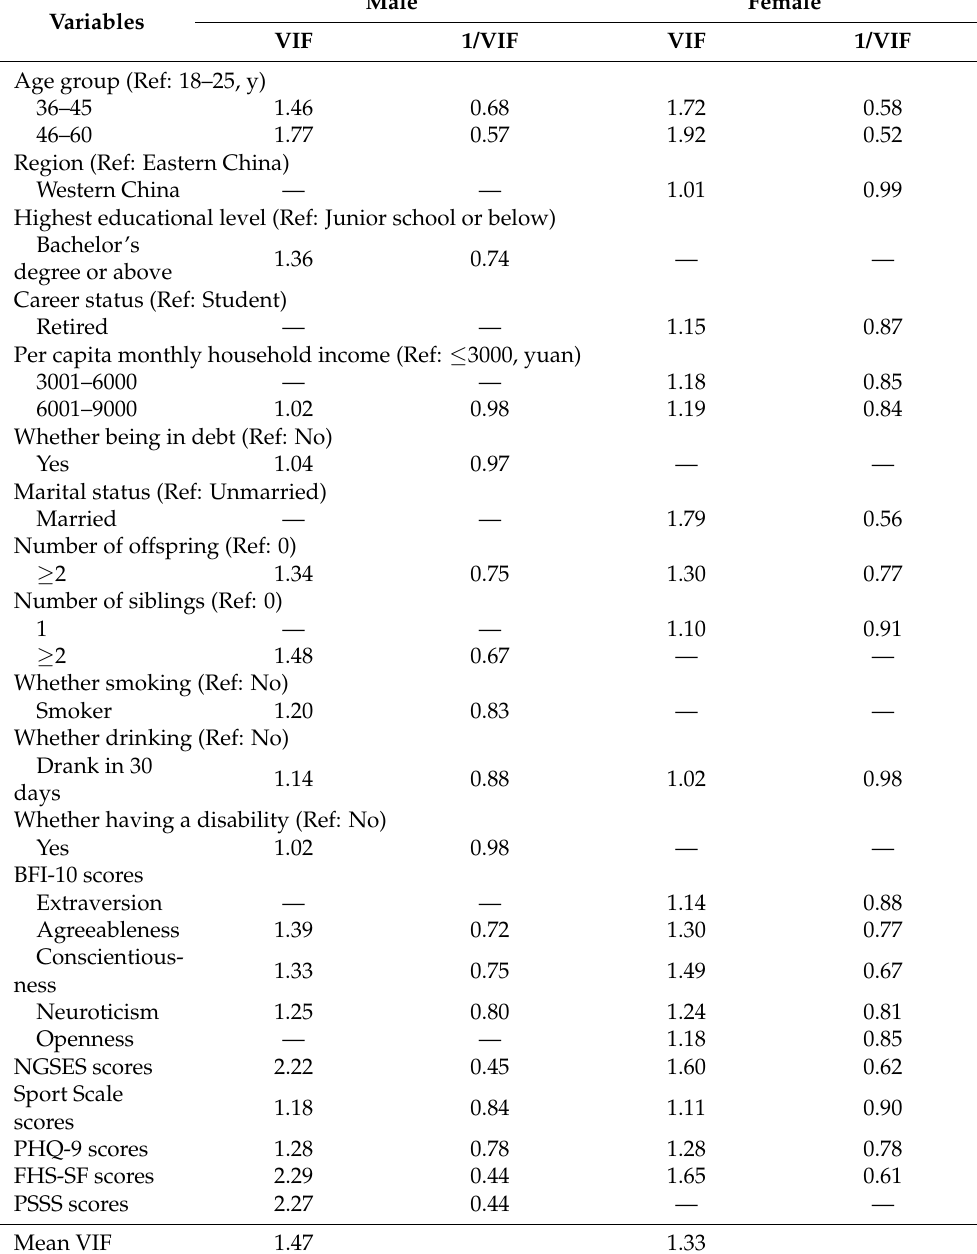
Table A6. The variance inflation factor of variables in stepwise regression analysis stratified by sex.